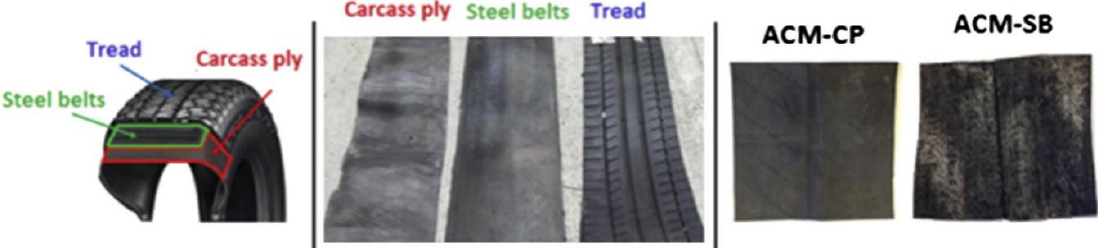
Figure 13. Description of the tire parts used for the development of the ACM systems based on carcass ply (ACM-CP) and steel belts (ACM-SB) [29].